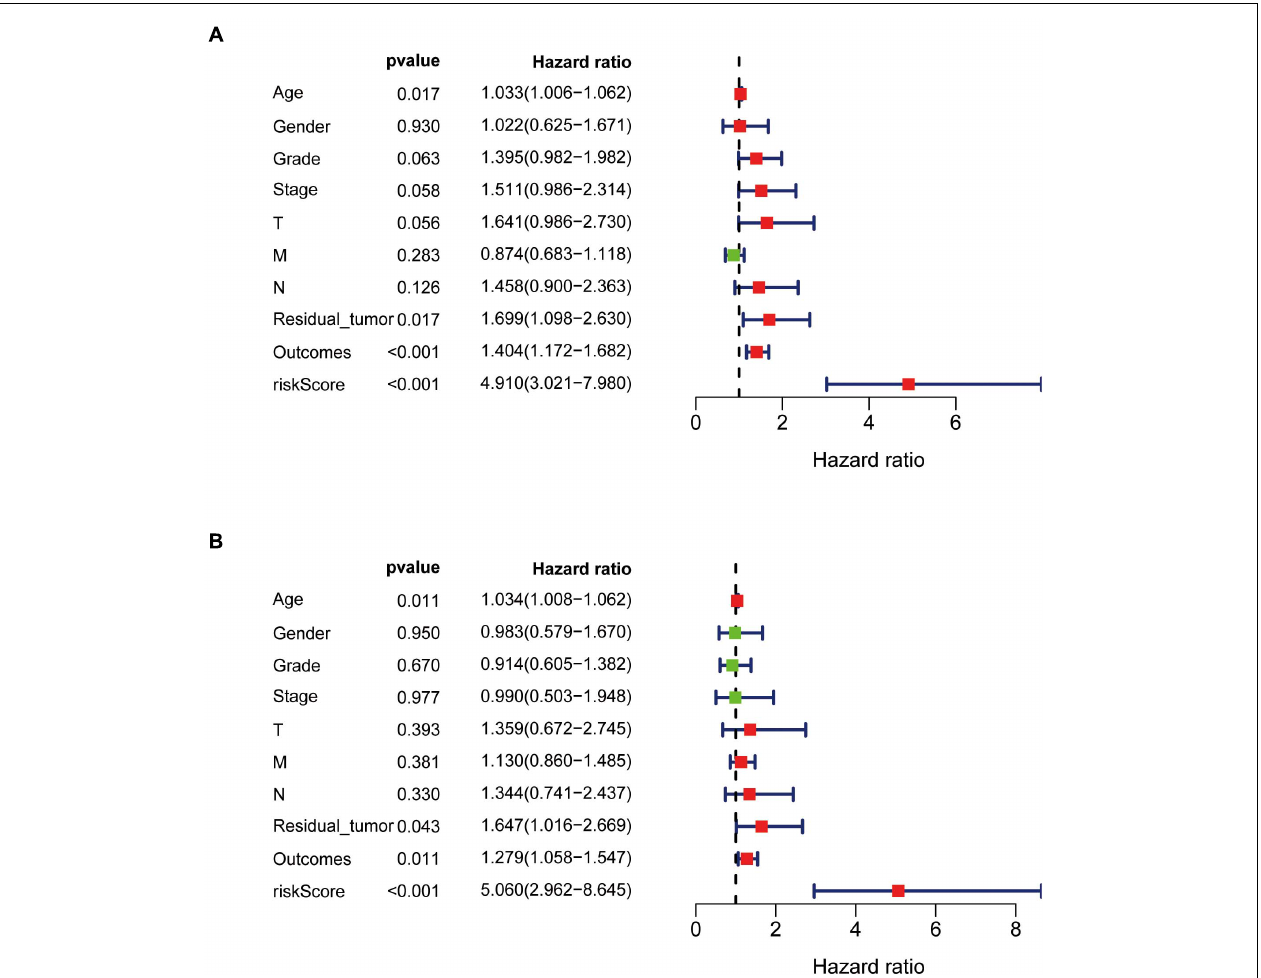
FIGURE 7 | Univariate and multivariate independent prognostic analysis in PAAD. (A,B) Forest plots of univariate and multivariate independent prognostic